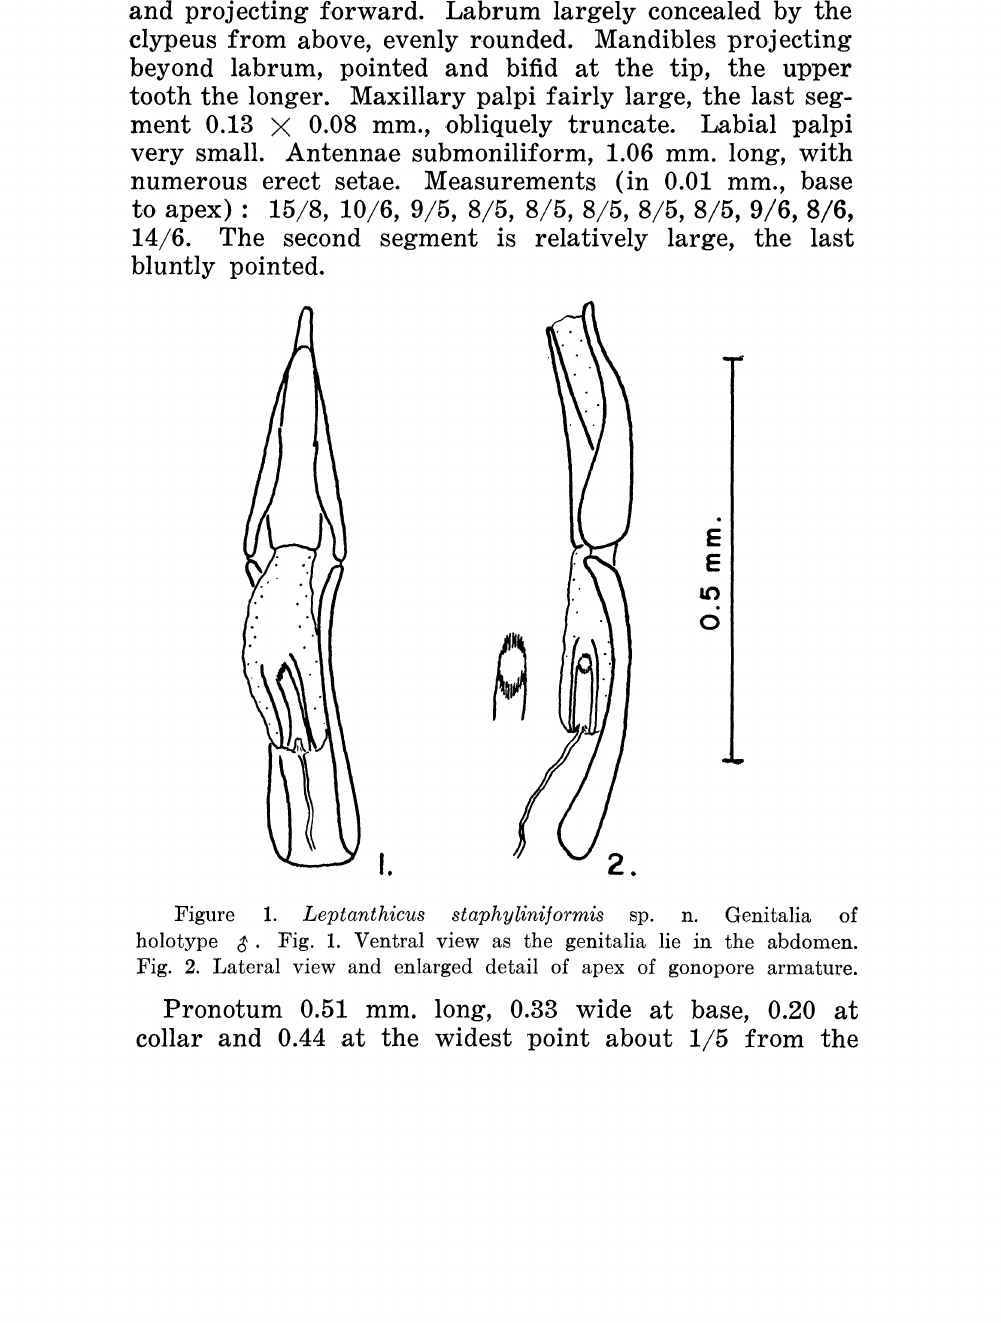
Figure 1. Leptanthicus staphylini]ormis sp. n. Genitalia of holotype 3. Fig. 1. Ventral view as the genitali lie in the abdomen. Fig. 2. Lateral view and enlarged detail of apex of gonopore